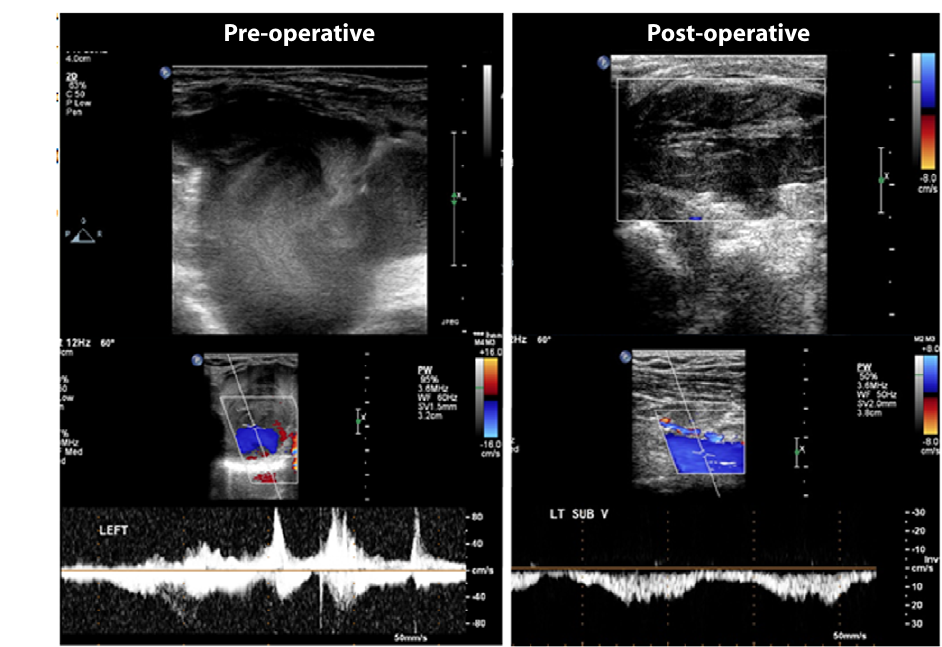
Figure 2. Duplex scanning of the left side of the root of neck. Pre-operative: 2D image showing a huge venous sac with whirling of blood. Respiro-phasic Doppler waveform accentuated by Valsalva maneuver confirms its venous communication; post-operative: color image showing totally thrombosed venous aneurysm with absent flow. Doppler waveform at the left subclavian vein shows normal venous flow. localized pain. They rarely present with complications including thromboembolism, rupture, venous obstruction and compression of adjacent structures